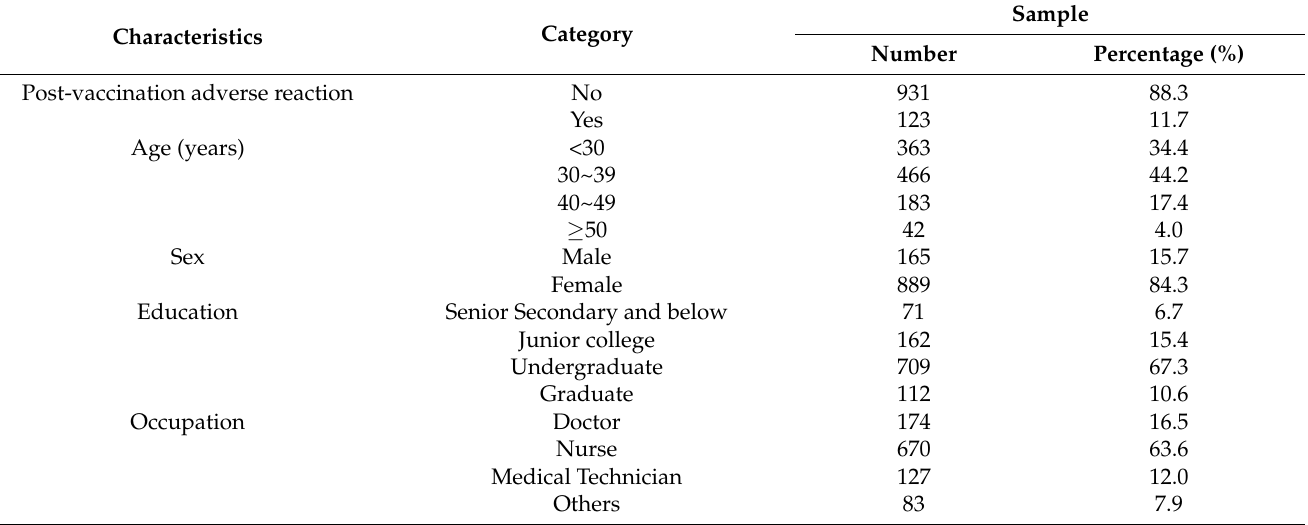
Table 1. Baseline characteristics of the healthcare workers (N n =